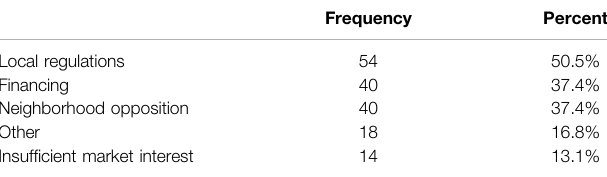
TABLE 7 | Challenges encountered to mixed-use development.